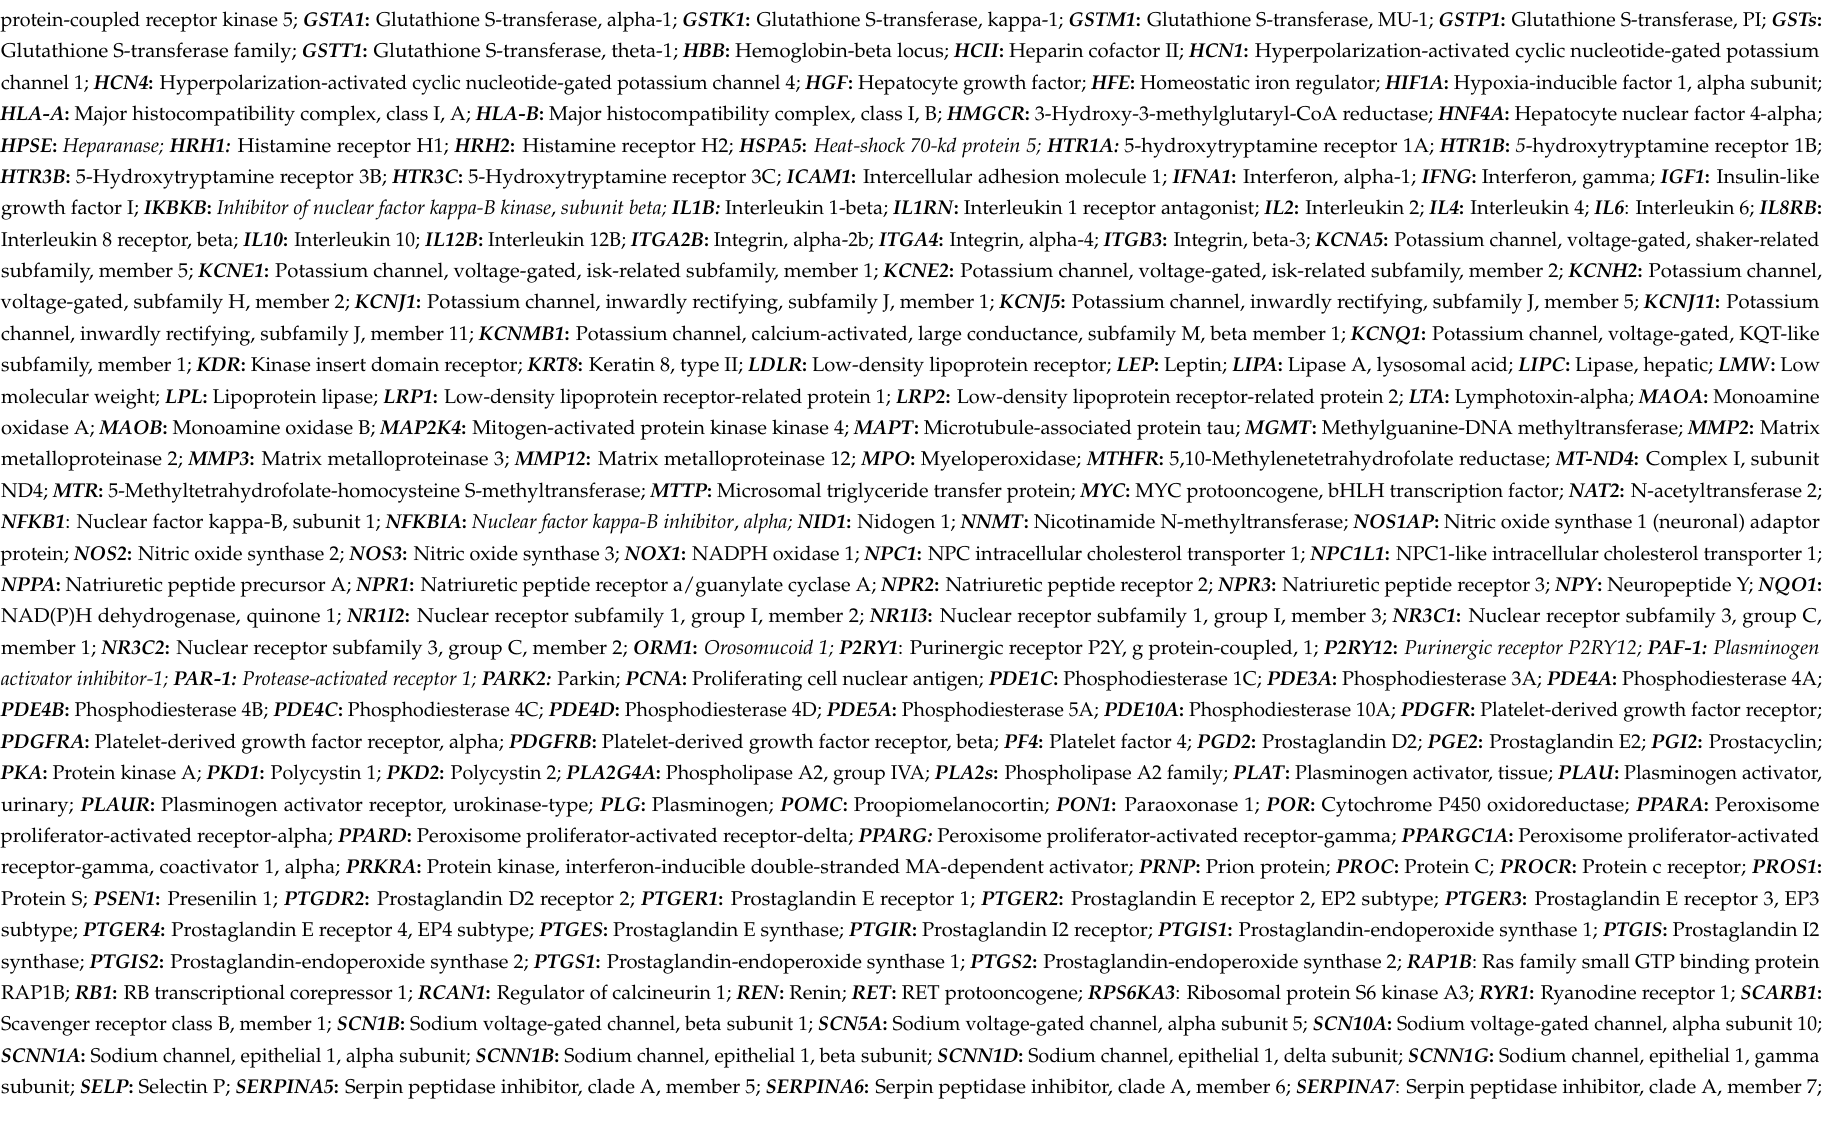
protein-coupled receptor kinase 5; GSTA1 : Glutathione S-transferase, alpha-1; GSTK1 : Glutathione S-transferase, kappa-1; GSTM1 : Glutathione S-transferase, MU-1; GSTP1 : Glutathione S-transferase, PI; GSTs